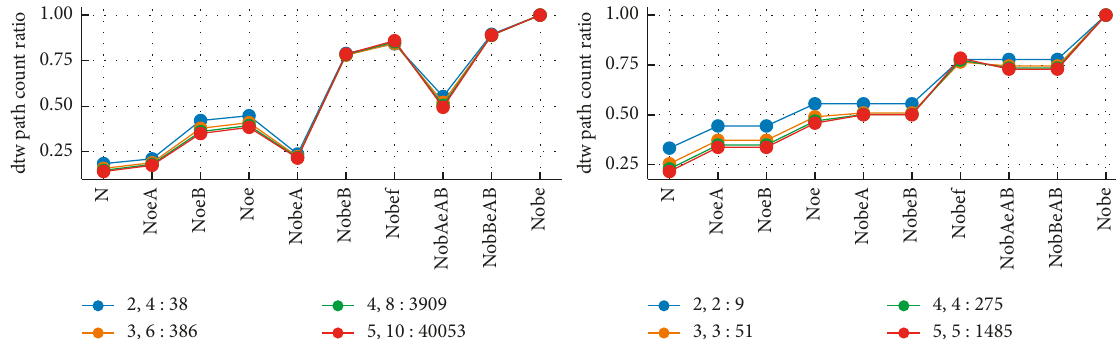
Figure 3: Number of matched schemes between different generalized